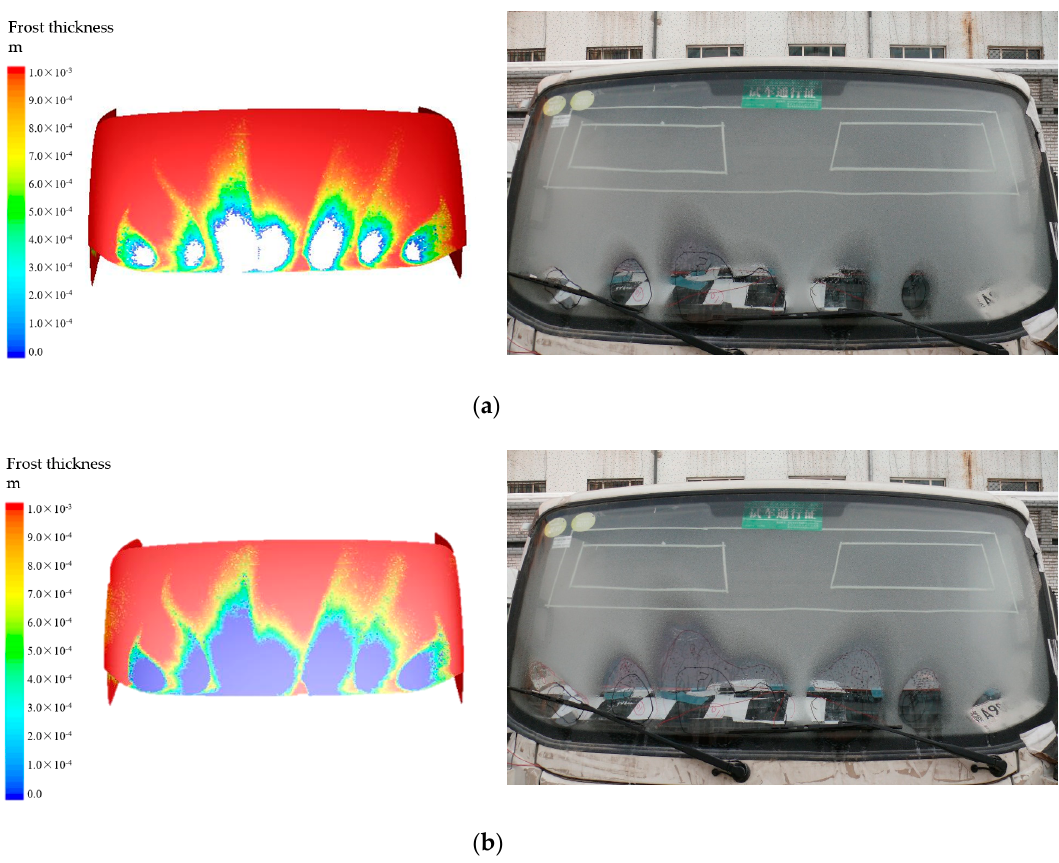
Figure 5. Qualitative comparison of the defrost effect between the numerical results and experimental data: ( a ) 15 min defrosting effect; ( b ) 20 min defrosting effect.